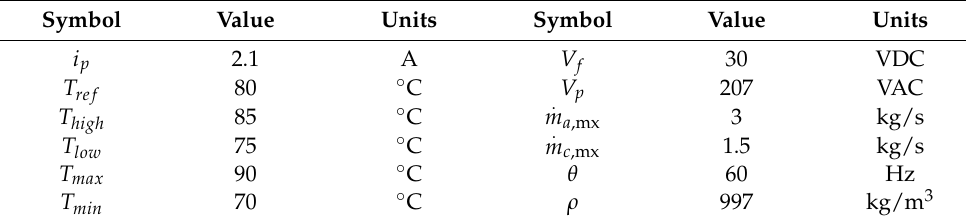
Table 1. Summary of system parameters.